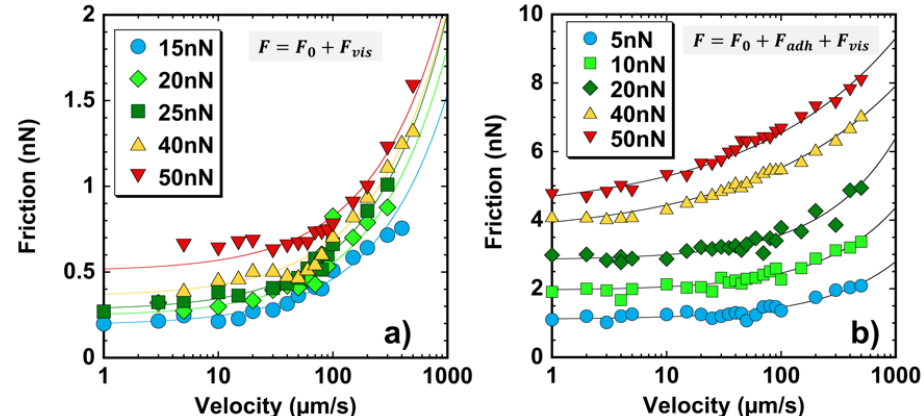
Figure 13. Fits of the viscous-adhesive model to the measured friction vs. sliding velocity for ( a ) agarose 1wt% hydrogels and ( b ) PAAm-9% hydrogels. The viscous contribution presumes a shear-thinning model ( n = −0.32) for both systems. The agarose hydrogel forms a repulsive contact and hence the adhesive contribution to friction is zero. Data for Figure 13b used with permission from Ref. [23].